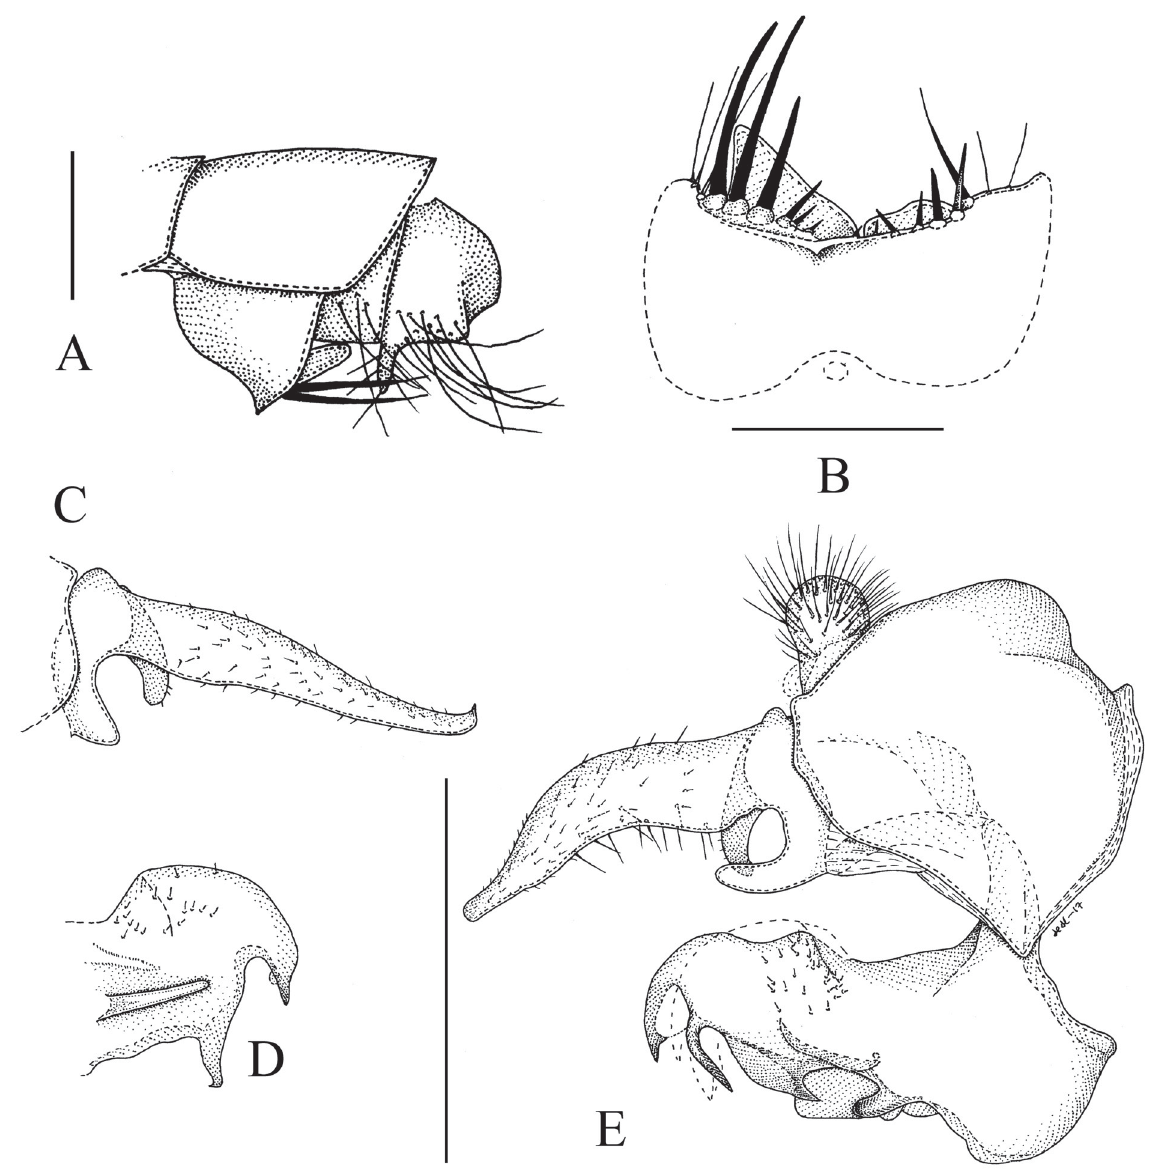
Fig. 71. Sphegina (Asiosphegina) ornata sp. nov., holotype, ♂ . A . Posterior part of abdomen, left side lateral view. B . Sternum IV, ventral view. C . Left surstylus, lateral view. D . Left superior lobe with associated parts, lateral view. E . Genitalia, right side, lateral view. Scale bars =